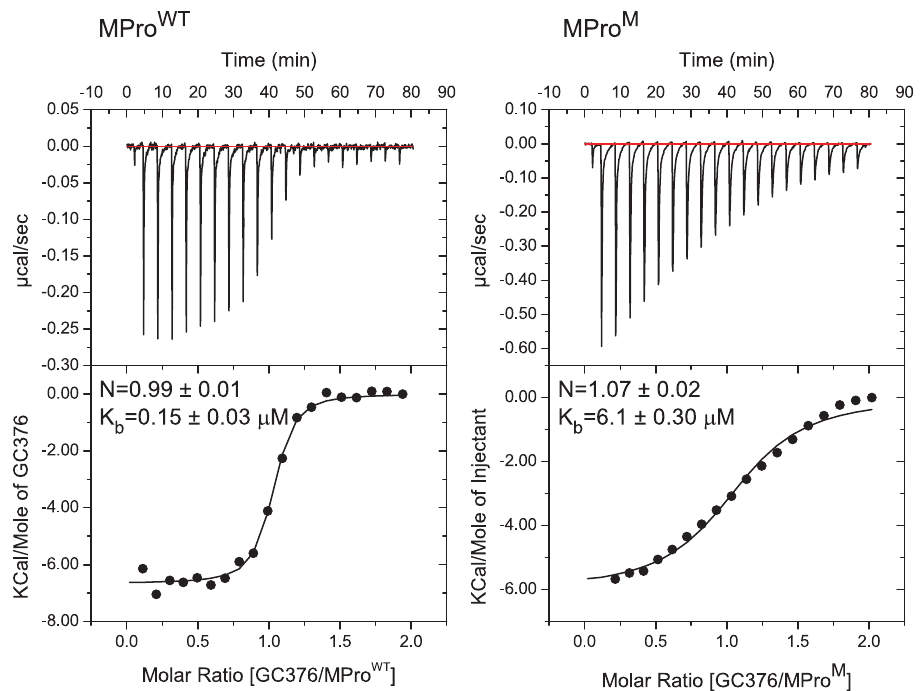
Fig. 7 Binding isotherm of GC376 to MPro WT and MPro M . Titrations were carried out with 30 µ M MPro WT and 98 µ M MPro M (in the cell) vs 300 µ M and 1 mM GC376 (in the syringe), respectively, in buffer C at 28 °C. Thermodynamic parameters are listed in Supplementary Table